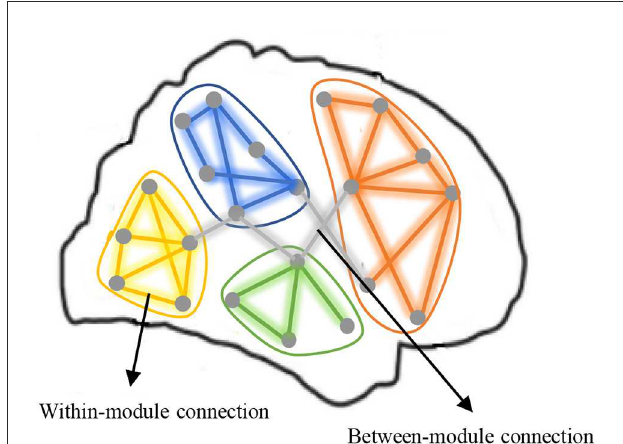
FIGURE1 A functional brain network with multiple modules that have dense within-module connection and sparse between-module